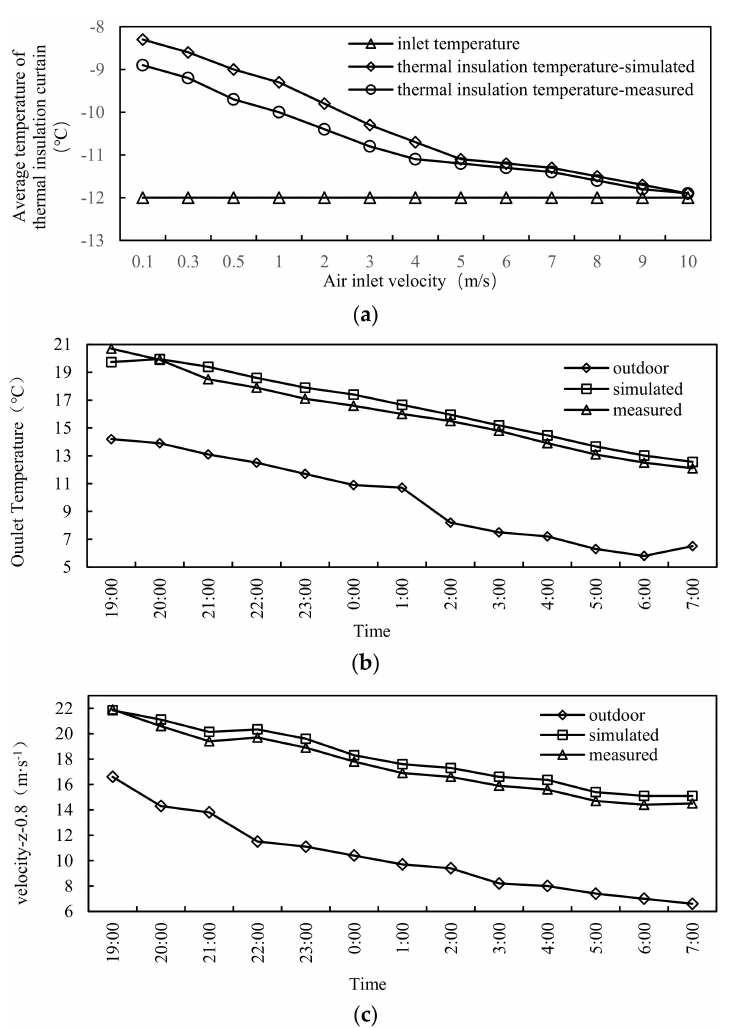
Figure 4. Comparison of simulated and measured temperature profiles: ( a ) average temperature, ( b ) outdoor temperature, and ( c )